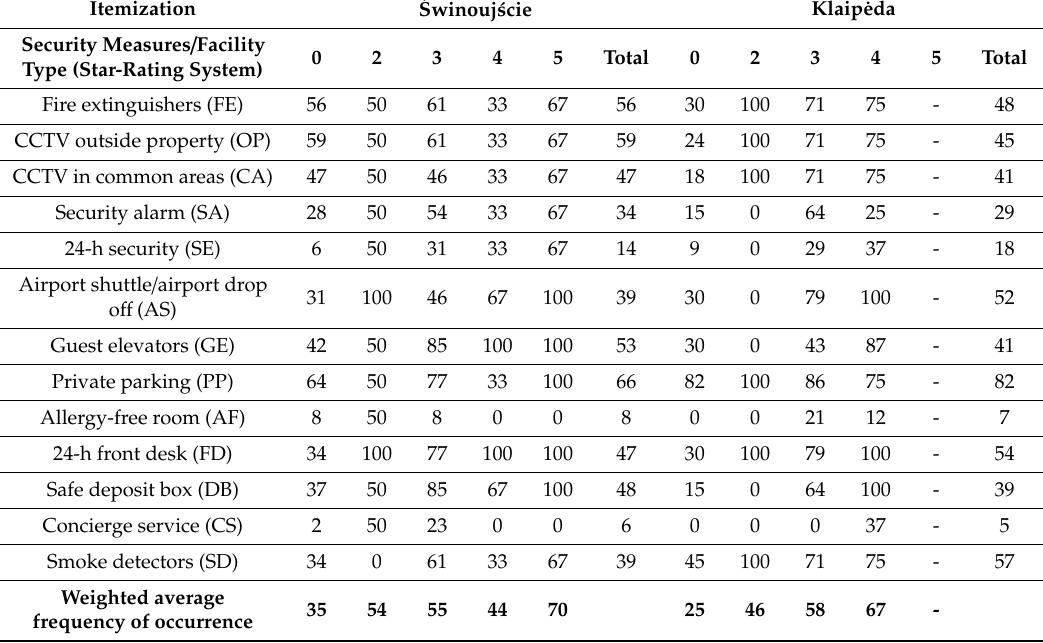
Table 3. Accommodation facilities where the security measures are installed (as a percentage of the total number of establishments of this type (in